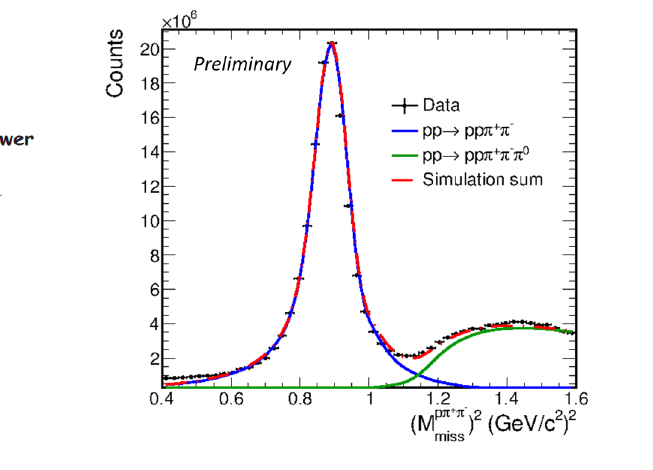
Figure 2. Squared missing mass distribution in the pp → pp π + π − X reaction compared to simulations for the two pion pro- duction (blue) and three pion production (green). The total is shown as a red